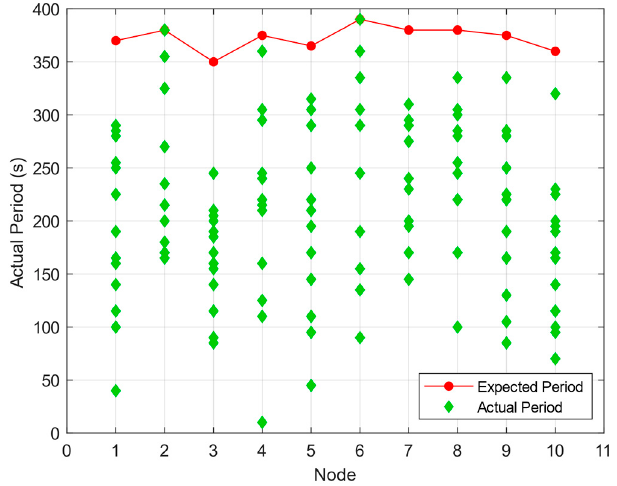
Figure 5. The actual monitoring period of task nodes obtained by the OMACO algorithm.